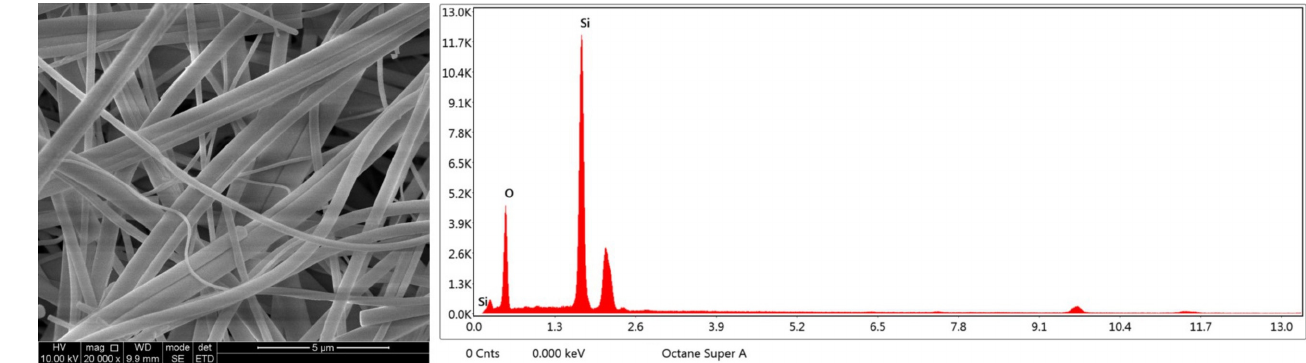
Figure 2. SEM micrograph and EDX spectrum of the blank filter membrane.